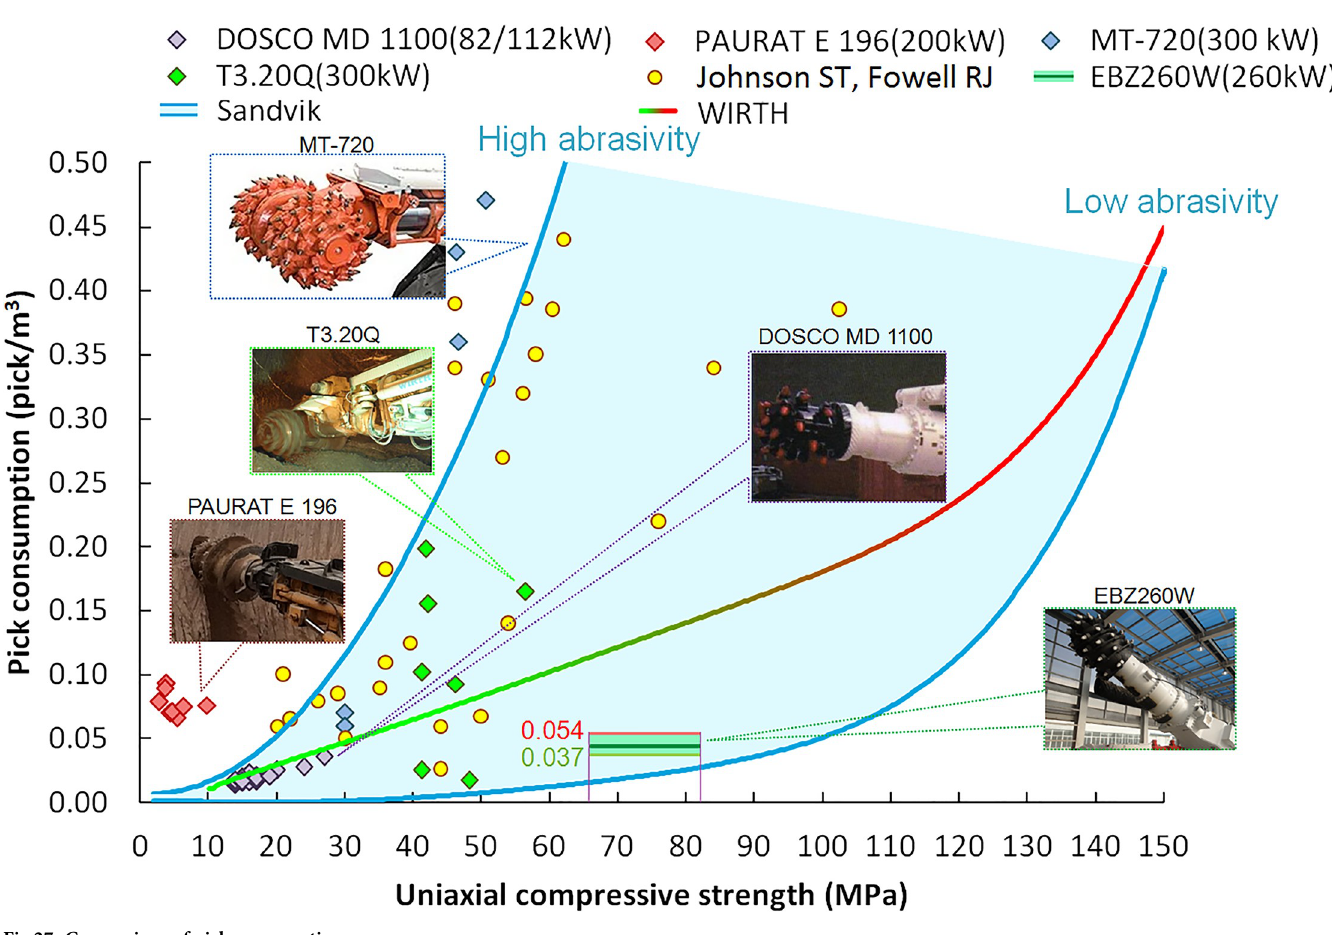
Fig 27. Comparison of pick